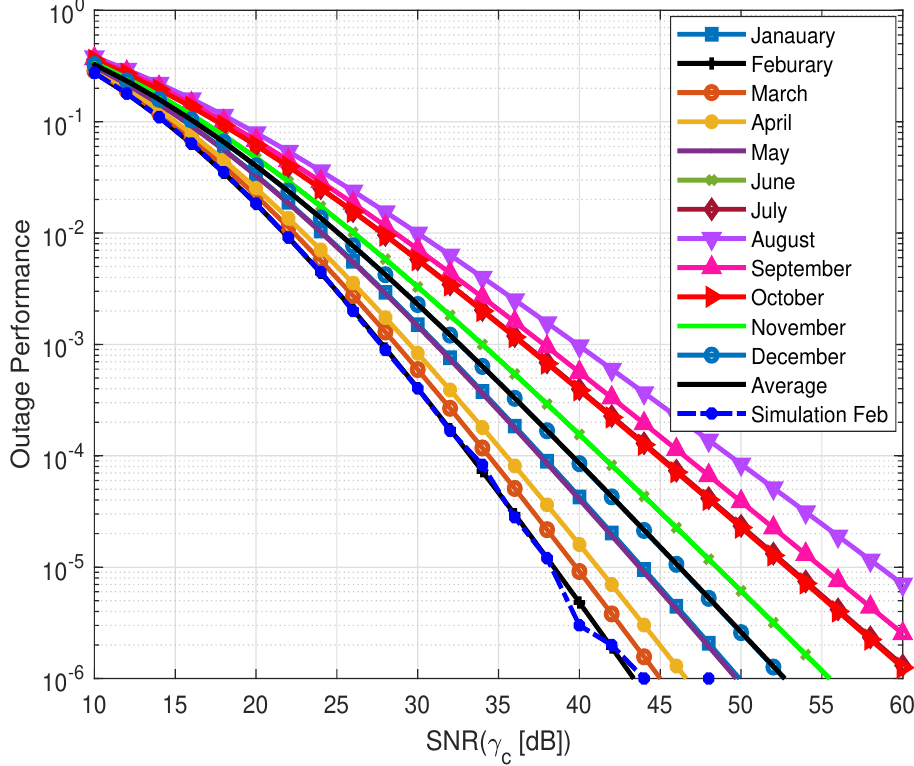
Figure 6. The observation of outage performance for whole year depicted in North Sea. The simulated outage performance included as in February. The outage performance is simulated based on the experimental data provided though the